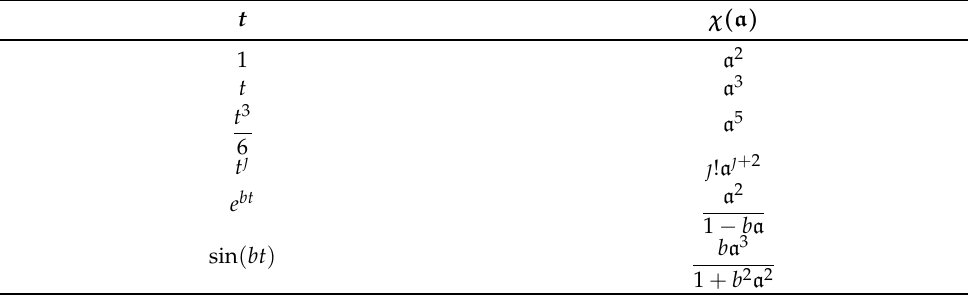
Table A1. Elzaki transform of some